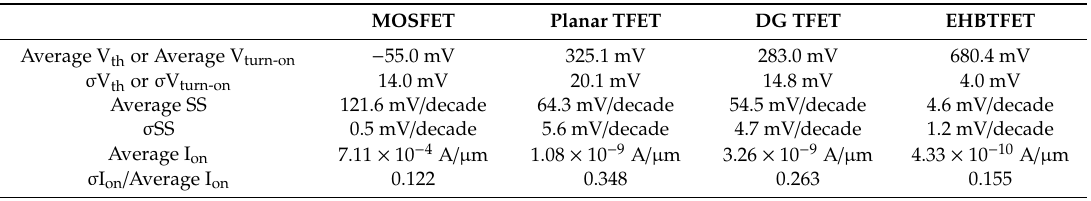
Figure 2. Transfer characteristics of the ( a ) MOSFET, ( b ) planar TFET, ( c ) DG TFET and ( d ) EHBTFET when the drain voltage (V D ) is 0.5 V. Table 2. Average and standard deviation of the turn-on voltage (V turn-on ), subthreshold swing (SS), and on-current (I on ) of the devices extracted from Figure 2.